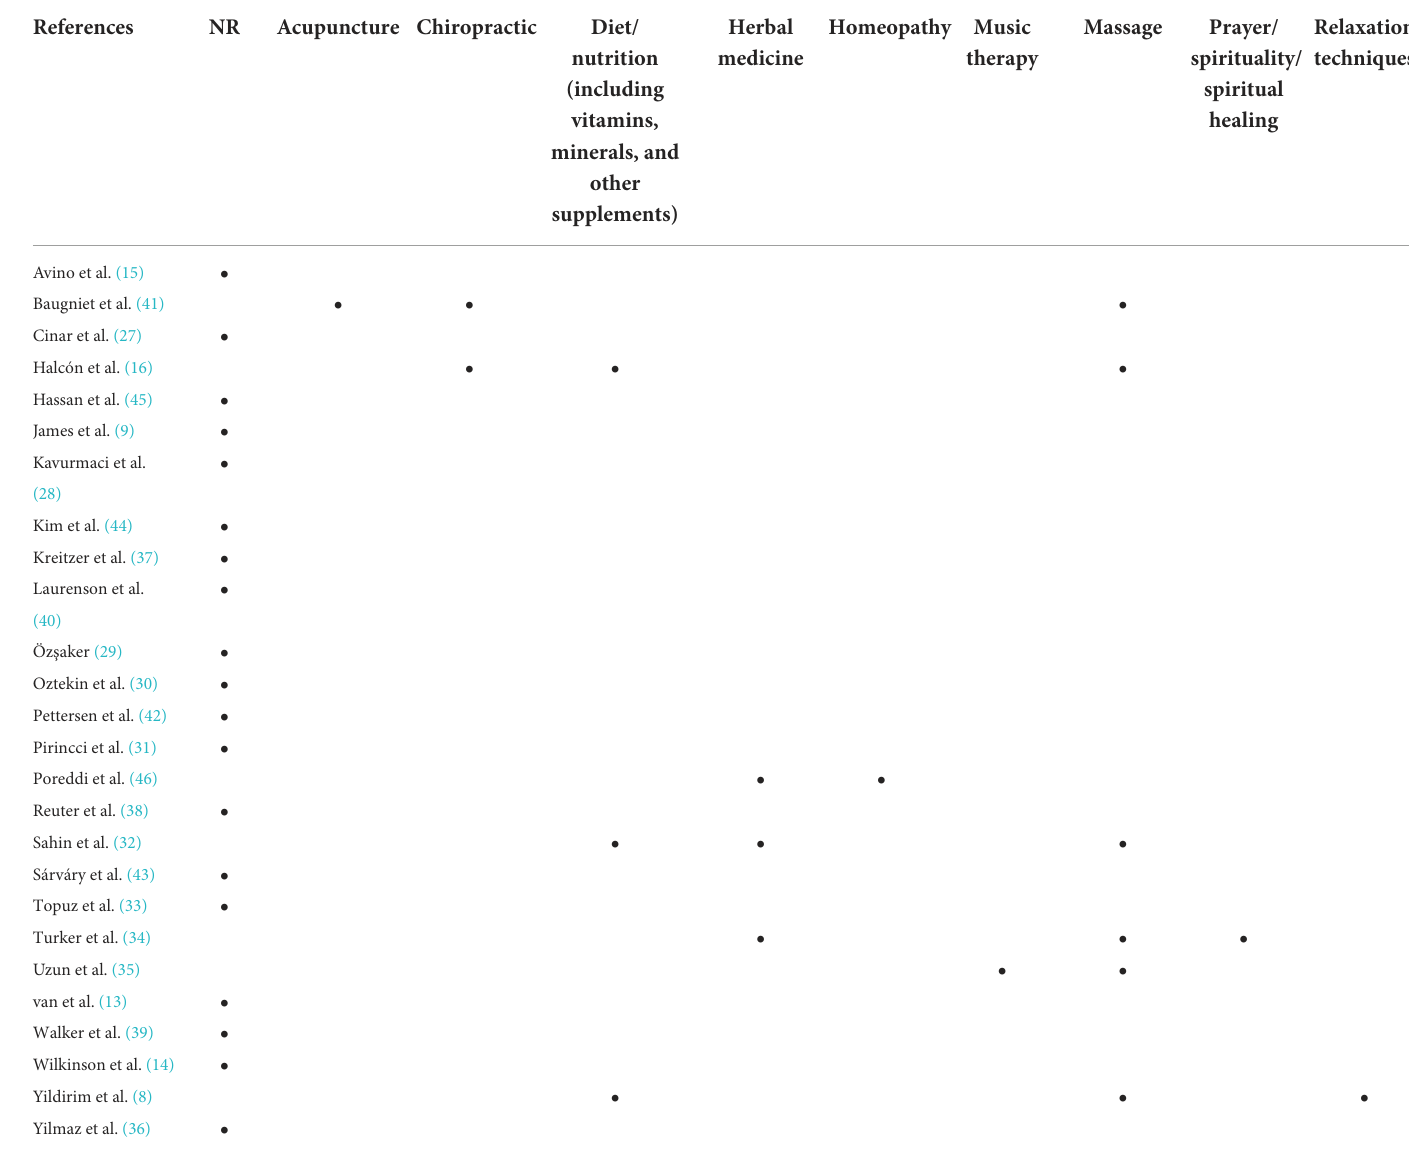
TABLE 5 Top three CAM modalities considered to be the most effective by nursing students in each